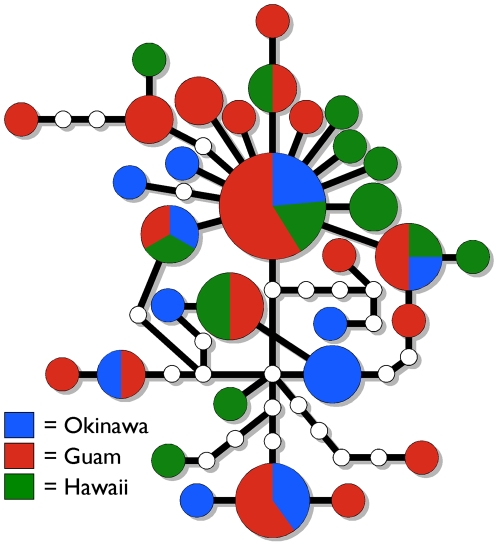
Haplotype network of COI sequences from 67 individuals of Conus ebraeus at Okinawa, Guam and Hawaii.Haplotypes are illustrated as circles, with hypothetical haplotypes that were not observed illustrated as small, empty circles. Areas of circles are proportional to the haplotype frequencies; pie diagrams illustrate frequencies of haplotypes at each location.